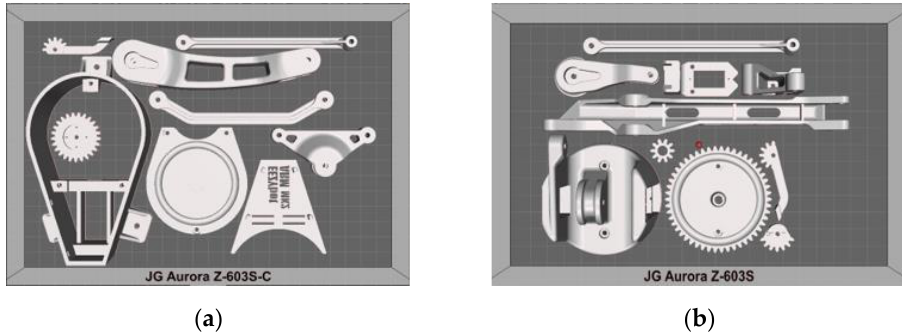
Figure 7. Results of the part-to-printer assignment with nesting: ( a ) Machine 1; ( b ) Machine 2.